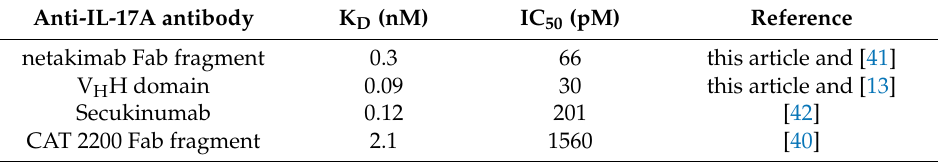
Table 4. Anti-IL-17A antibodies. K D for antibody-cytokine complexes and half-maximal inhibitory